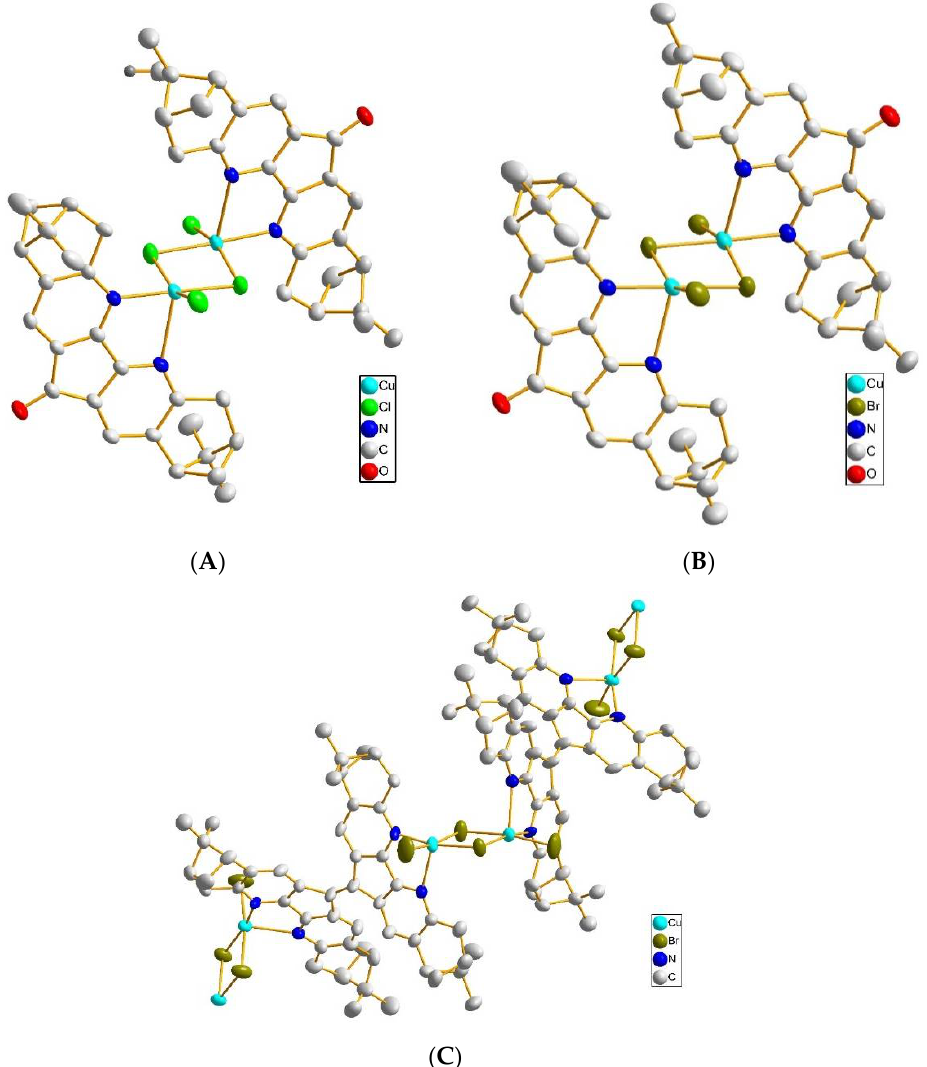
Figure 1. Structures of complexes 1 ( A ), 2 ( B ) and 4 ( C ). Table 1. Selected bond lengths (Å) and angles ( ◦ ) for 1 , 2 and 4